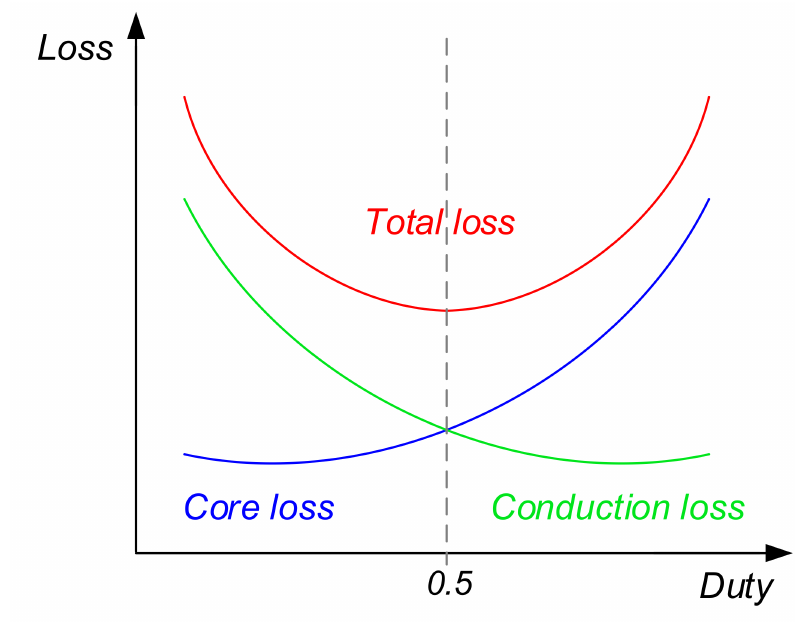
Figure 8. Variation of Loss with